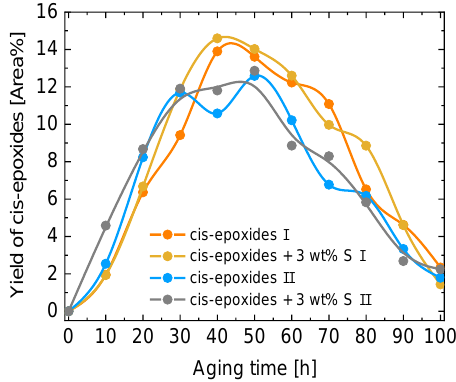
Figure 12. GC–MS measurement to record the yield of cis-epoxide while aging the blends over time. On the one hand, the orange line (C18:1) and the yellow line (C18:1 + 3 wt% S) represent the first measurement. On the other hand, the blue line (C18:1) and silver line (C18:1 + 3 wt% s) depict the repeat measurement ( n = 2). I describes the first, II the second measurement.